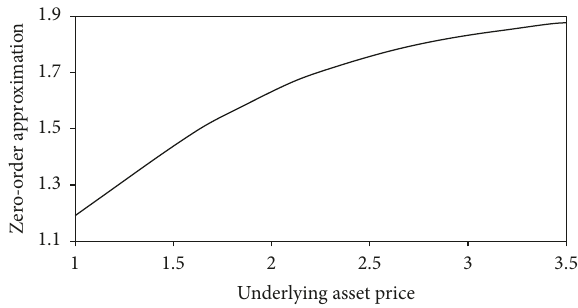
Figure 1: Zero-order approximation of the collar option.